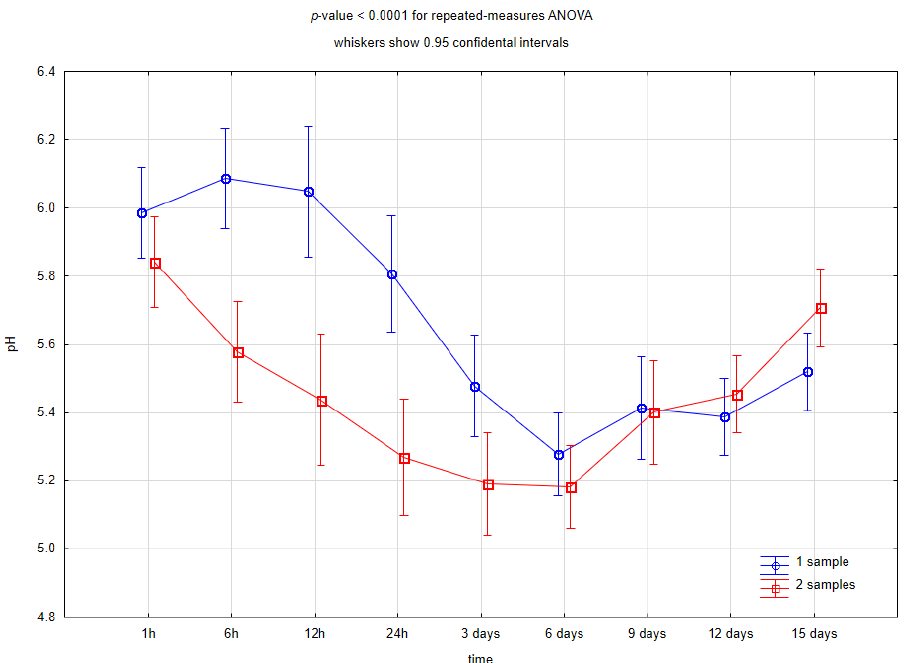
Figure 8. Repeated-measures analysis of variance for pH values in the individual time points depending on the number of the samples for Evetric.